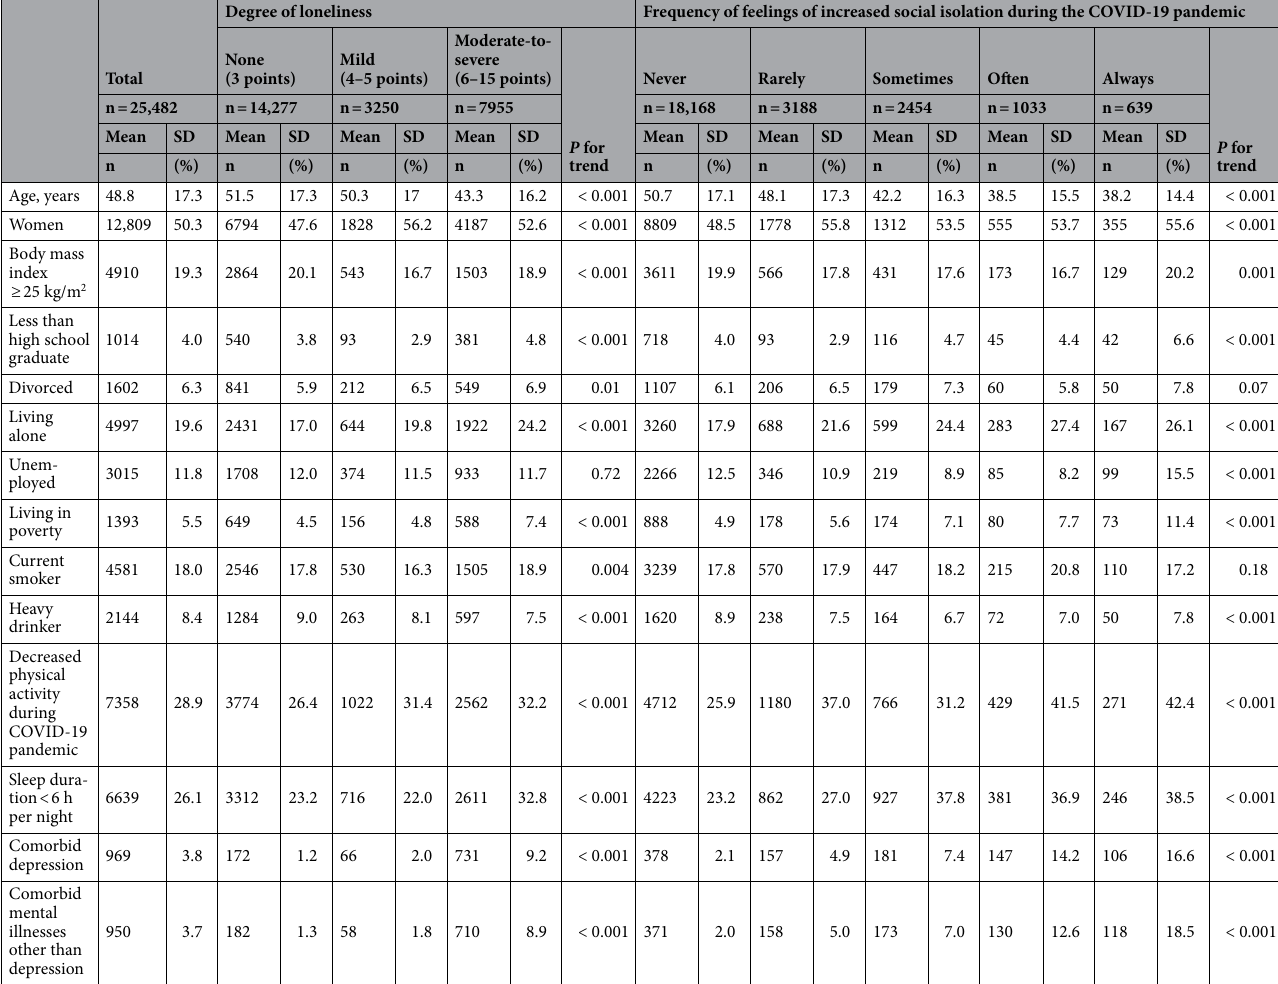
Table 1. Mean values and proportions for participant characteristics (n = 25,482). COVID‑19 coronavirus disease 2019, SD standard deviation. Loneliness was measured using theJapanese version of the University of California, Los Angeles Loneliness Scale (Version 3), Short Form 3-item tool. Poverty was defined as an equivalized income less than 1.22 million Japanese yen. Individuals with alcohol consumption ≥ 46 g per day were defined as heavy drinkers. P for trend values were calculated using a generalized linear